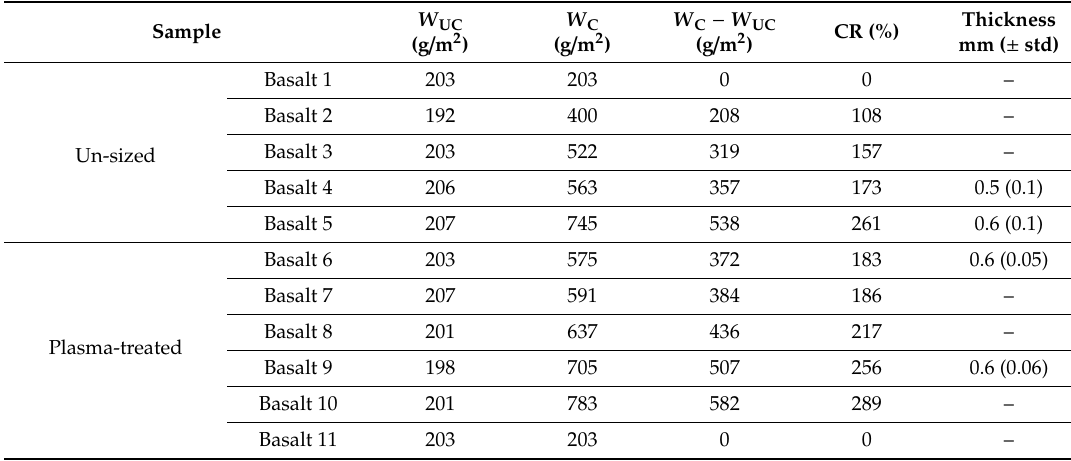
Table 1. Details of mass per unit area and silicone add-on ( W c − W uc ) of un-sized and plasma-treated basalt fabrics coated with di ff erent silicone content (CR